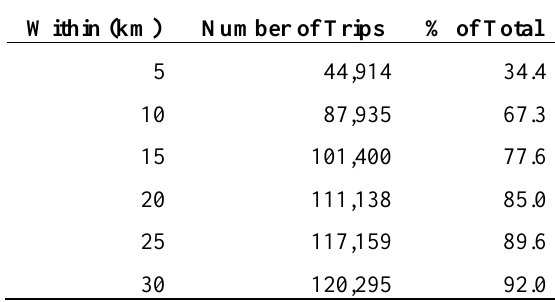
Table 2. Commuting trips within a specific Euclidian distance. Within